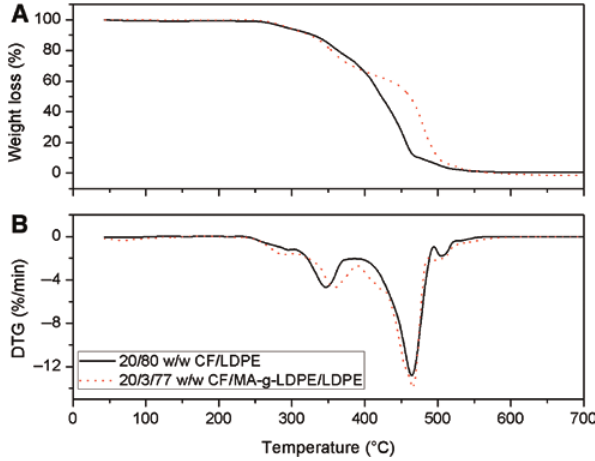
Figure 6: TG (A) and DTG (B) curves of CF/LDPE composites at 20 wt% fiber loading with or without compatibilizer.